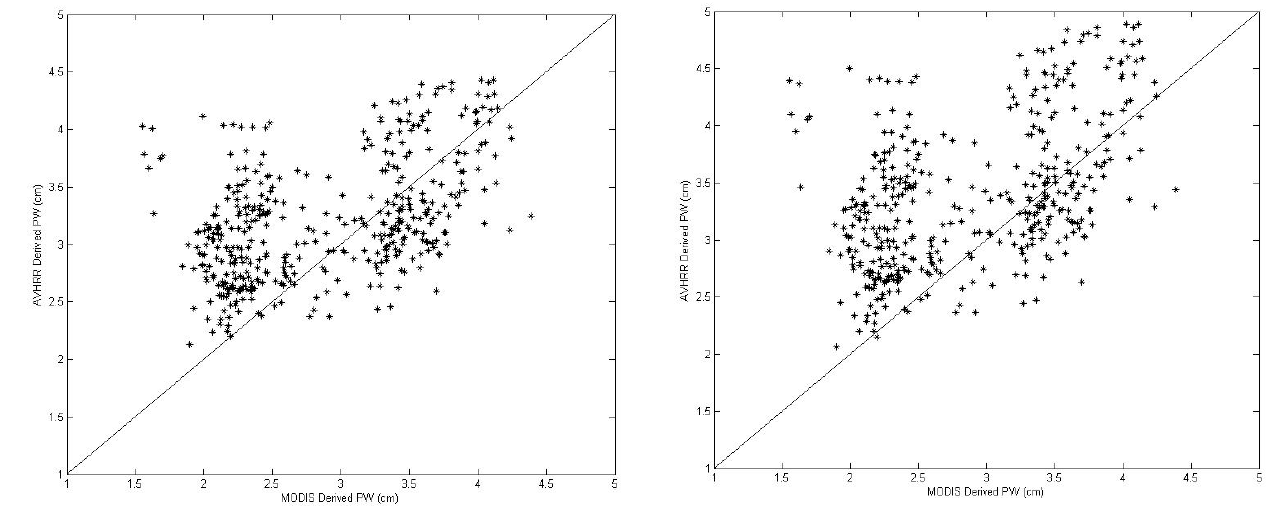
Fig. 4. Scatterplot of MODIS derived PW versus AVHRR derived PW values calculated using the relationship formulated for the study area.